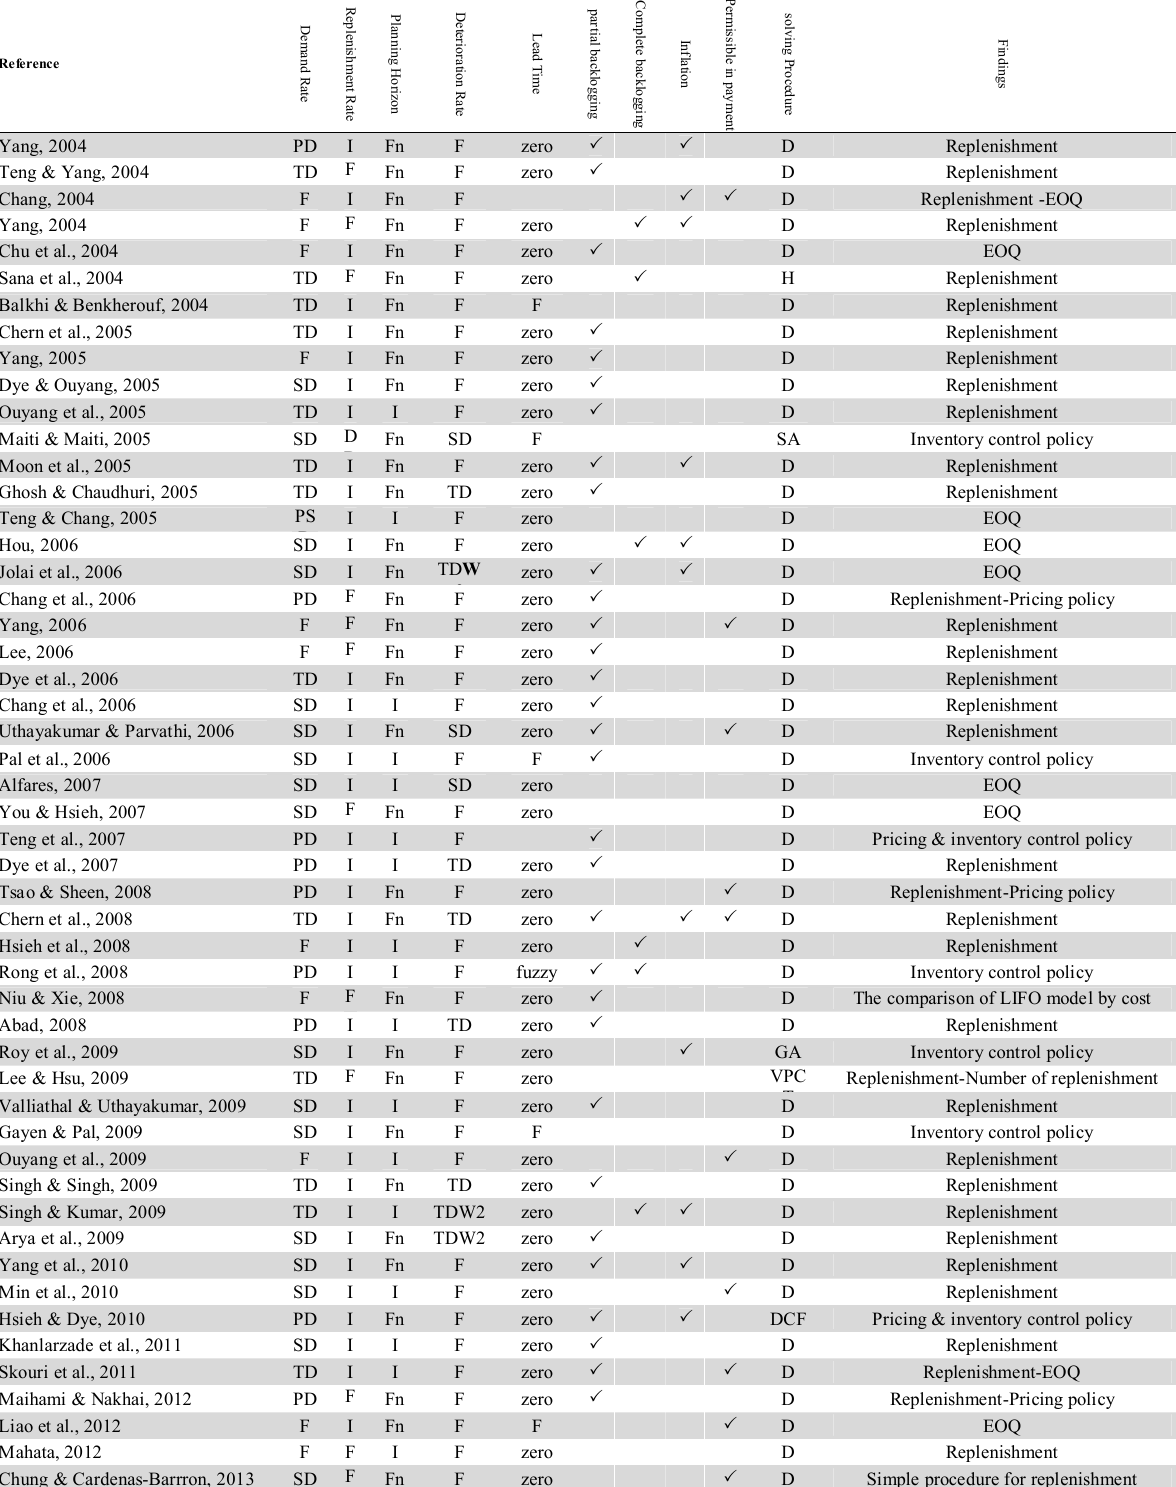
Classification of deteriorating inventory control for one-echelon supply chain